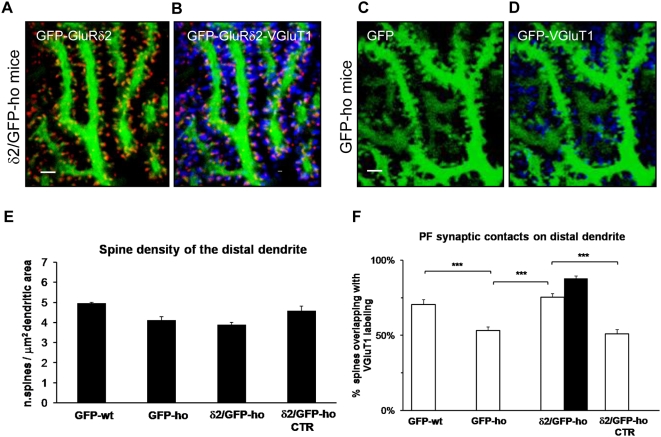
GluRδ2 promotes formation of PF contacts in the PC distal domain of δ2/GFP-ho mice.(A–D) Immunostaining of PF innervations on PC distal dendrites of δ2/GFP-ho mice (A–B) and GFP-ho mice (C–D). GFP spines bearing GluRδ2 (red, A) are contacted by PF terminals labeled by VGluT1 antibody (blue) (B). (E–F) Histograms show the mean density of spines emerging from the distal dendritic domain and the percentage of spines contacted by the PFs in this compartment. (E) The mean spine density does not change between the experimental groups (p = 0.096). (F) The mean percentage of spines overlapping with VGluT1 is increased in δ2/GFP-ho mice relative to control ho groups (GFP-ho and δ2/GFP-ho CTR), while there is no significant difference between δ2/GFP-ho mice and the GFP-wt group. In the presence of GluRδ2, indicated as the percentage of spines expressing GluRδ2 (black column), the number of PF contacts reaches that of wild-type mice. *** p<0.001. Error bars indicate SE. Scale bars:  = 2 µm.